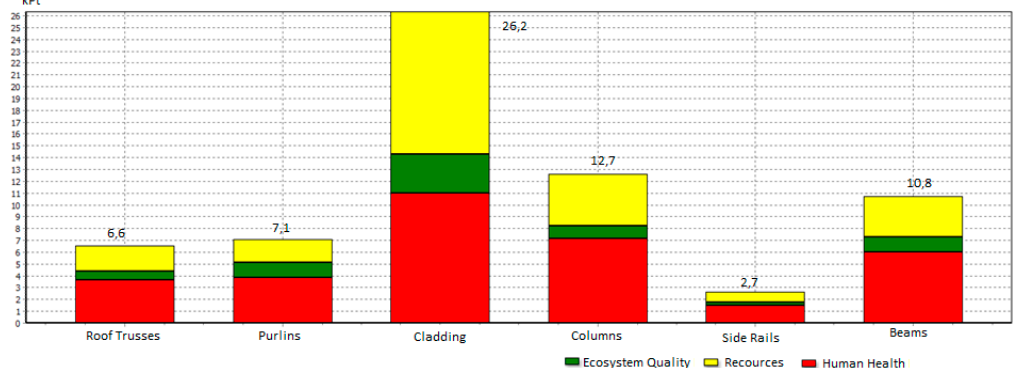
Figure 4. Single score comparison using Eco-Indicator 99 methodology of production and utilization of structural steel in buildings.